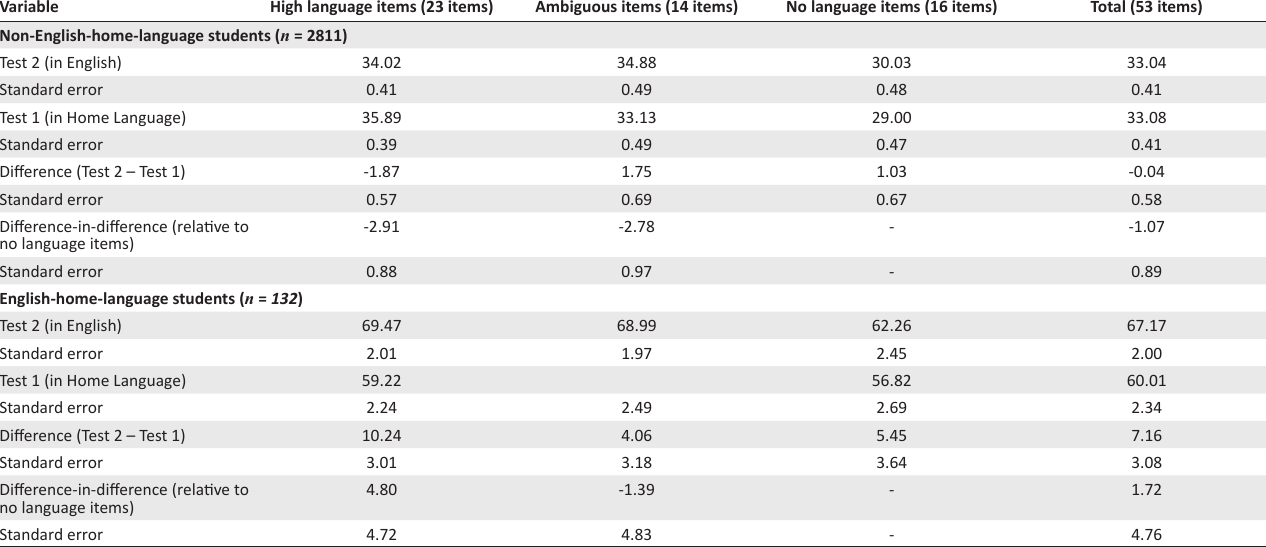
TABLE 10: Average numeracy performance ( % ) by language-content in Test 1 (Systemic Evaluation) and test 2 (National School Effectiveness Study) for students whose home language is not English (standard errors clustered at the individual level).